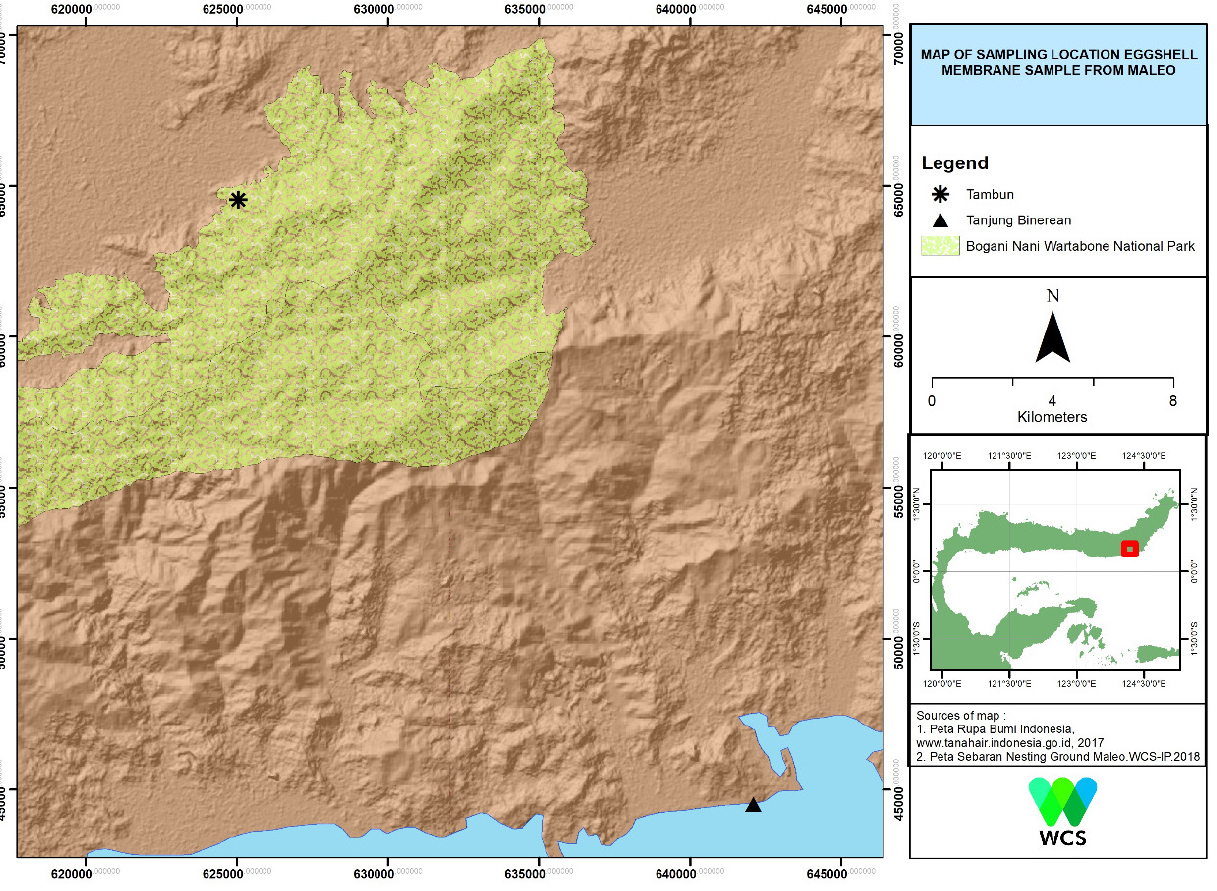
Figure 1. Sampling sites of eggshell membrane of Maleo ( Macrochepalon maleo ) in North Sulawesi,